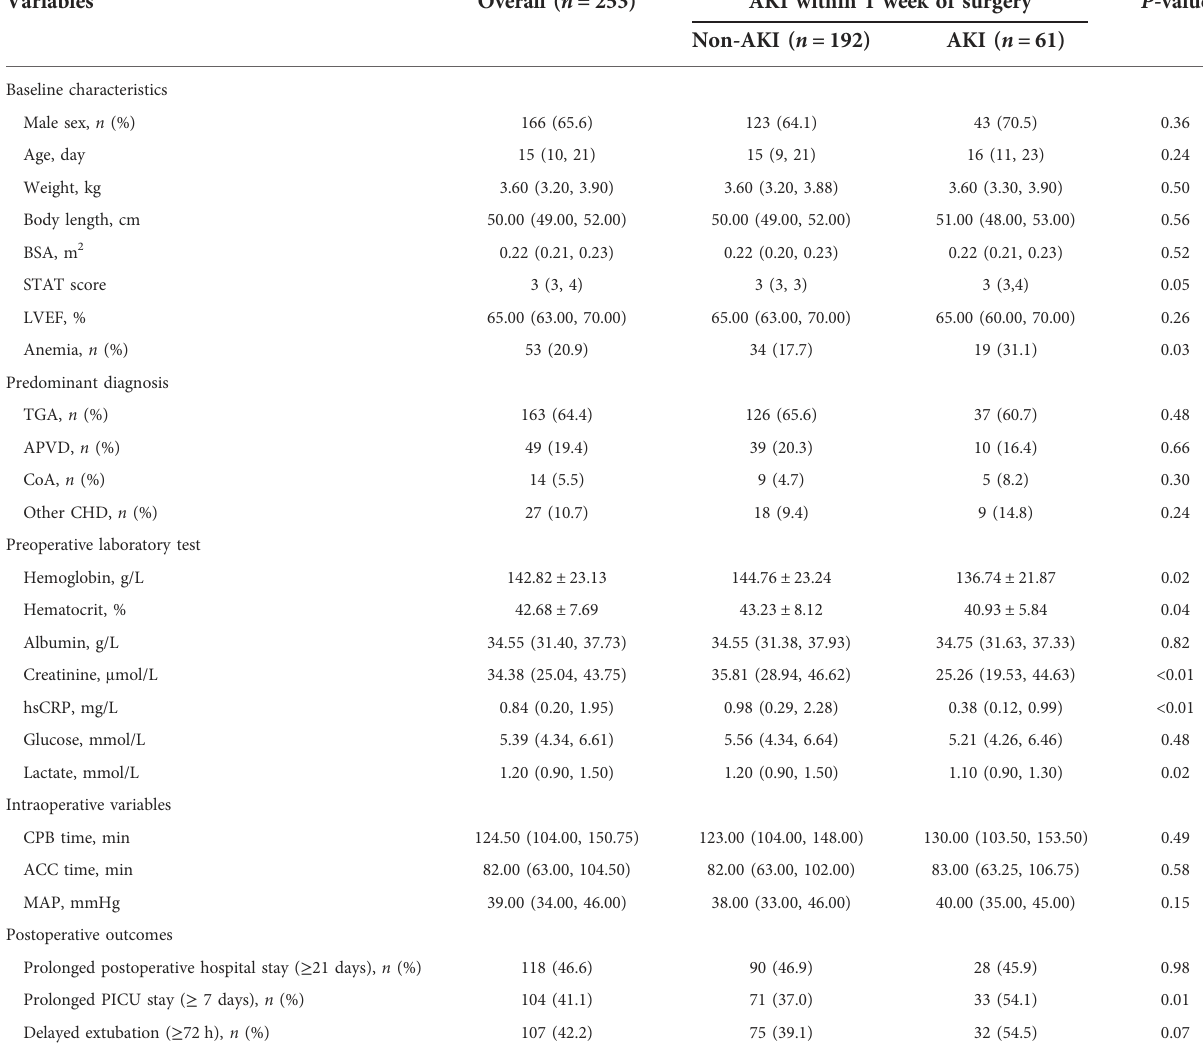
TABLE 1 Patient characteristics and perioperative information. Variables Overall ( n = 253) AKI within 1 week of